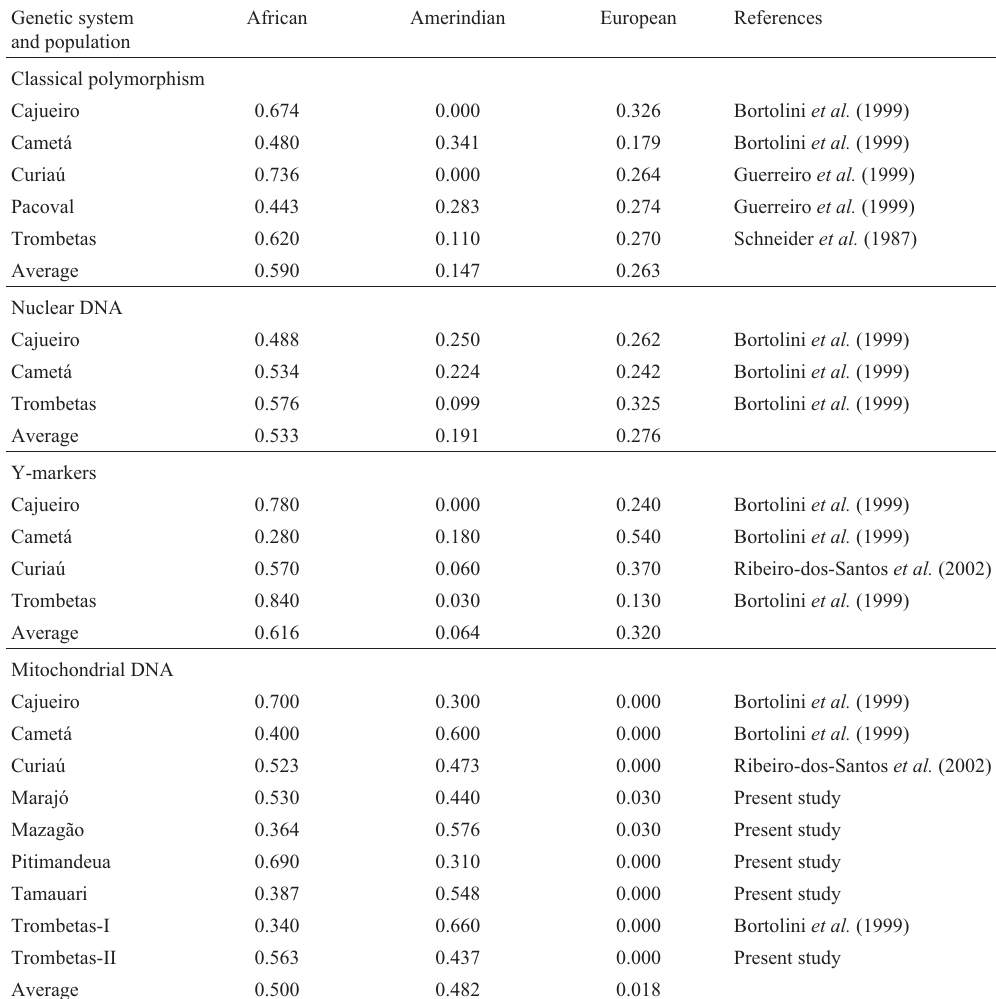
Table 3 - Estimates of parental contributions for African-derived populations from the Brazilian Amazon, considering uniparental and biparental genetic markers. Genetic system and